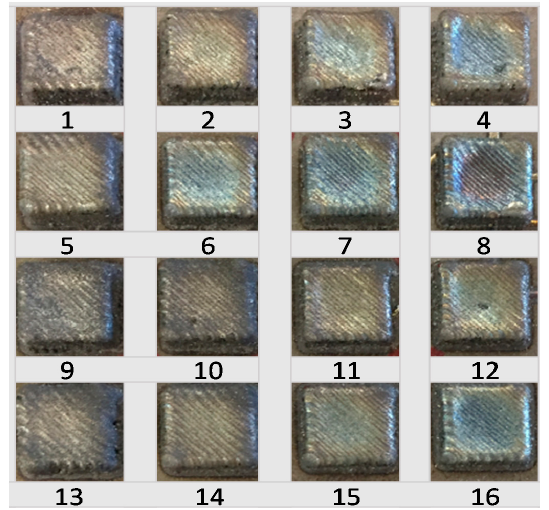
Figure 2. The dimension and shaping of the deposited blocks.